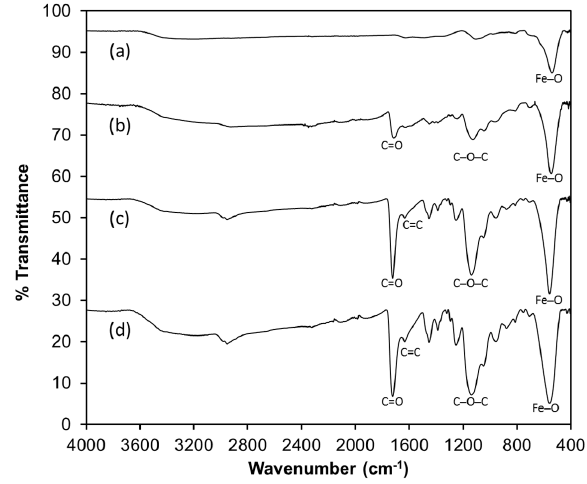
Figure 2. Fourier transform infrared (FTIR) spectra of the sorbents. ( a ) Fe 3 O 4 ; ( b ) Fe 3 O 4 -MAA; ( c ) Fe 3 O 4 -MAA-IL; ( d ) Fe 3 O 4 -IL. IL: ionic liquid; MAA: methacrylic acid.